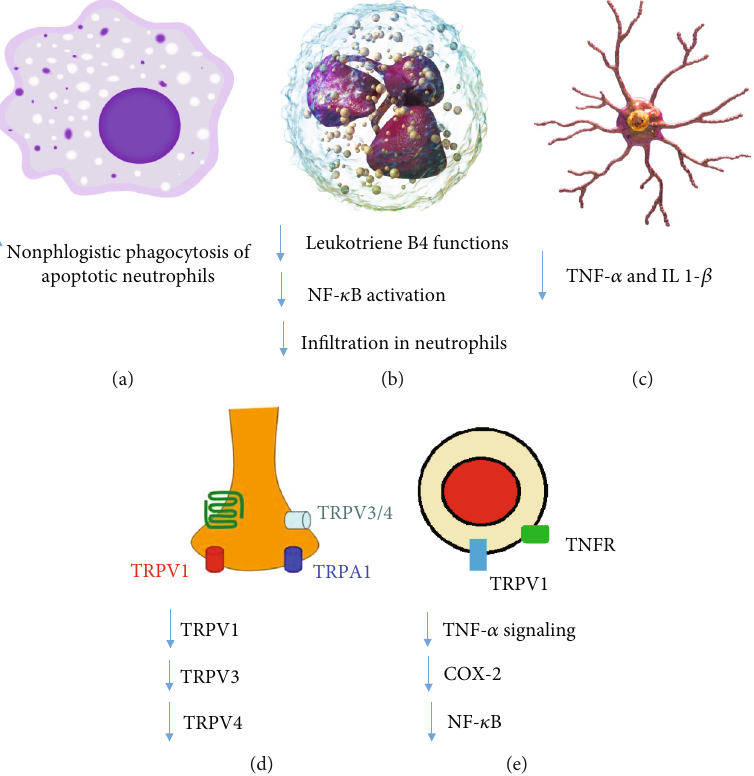
Figure 3: Biological role of SPMs in macrophages (a), neutrophils (b), microglia (c), synapse (d), and monocytes (e).